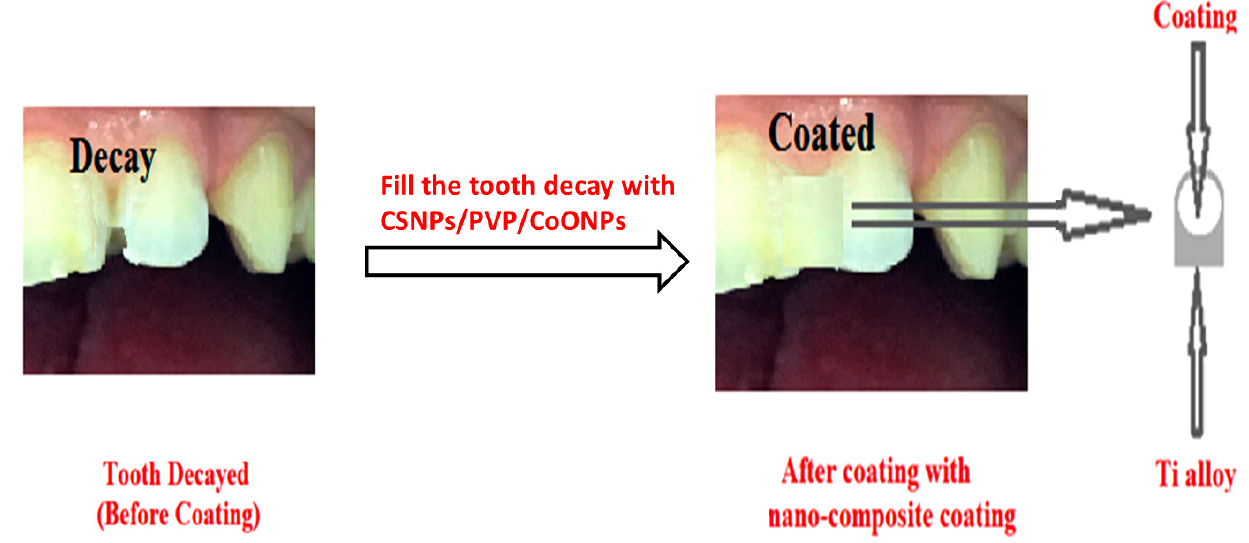
Figure 1. The case before and after coating the tooth.